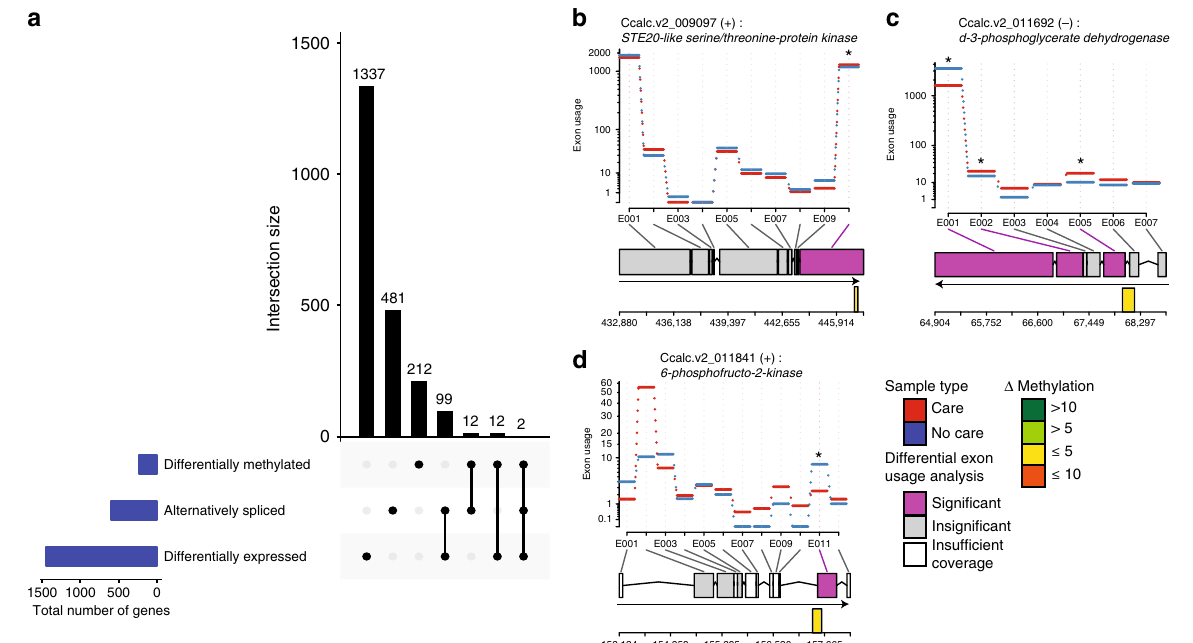
Fig. 4 Overlap among differentially expressed, alternatively spliced, and differentially methylated genes. a UpSet plot illustrating the intersection between genes containing differentially methylated regions called by MethylKit, alternatively spliced genes called using DEXseq and rMATS, and differentially expressed genes computed using edgeR. The nature of a given intersection is indicated by the dots below the bar plot. For instance, the 99 genes in the fourth column are alternatively spliced and differentially expressed but not differentially methylated. b – d DEXseq plots showcasing the instances where a DMR directly overlapped a differentially utilized exon. The top panel shows average exon usage for each treatment group. The gene model is represented below each exon usage plot with purple exons indicating statistical support for differential usage (FDR-corrected p -value <0.01). Direction of transcription is indicated by an arrow and DMRs are overlaid beneath the gene model with colors indicating the change in methylation